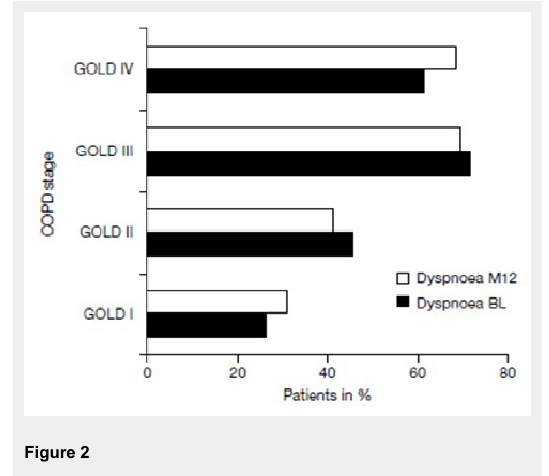
Prevalence of dyspnoea, after 12 months. Comparison of prevalence of dyspnoea at BL and after 12 months. No significant reduction after 12 months p = 0.24420. Abbreviations: COPD, chronic obstructive pulmonary disease; GOLD, Global Initiative for Chronic Obstructive Lung Disease; BL, baseline; M12, month 12.